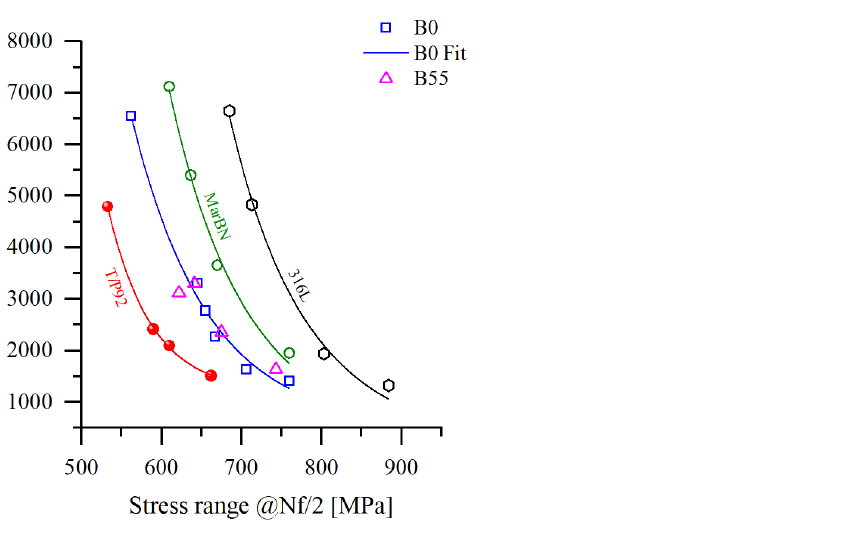
Figure 10. Thermomechanical fatigue testing ( ∆ T: 50–650 ◦ C, dT/dt: 10 Ks − 1 , ε mech. = − 1 to − 0.48 · ε therm. , no holding times at T min. /T max. ) results of the alloys B0 and B55 in comparison to advanced ferritic– martensitic grades (AFM: grade 92, MarBN) and stainless, austenitic steel (316L). B0, T/P92, MarBN, and 316L data from [7].